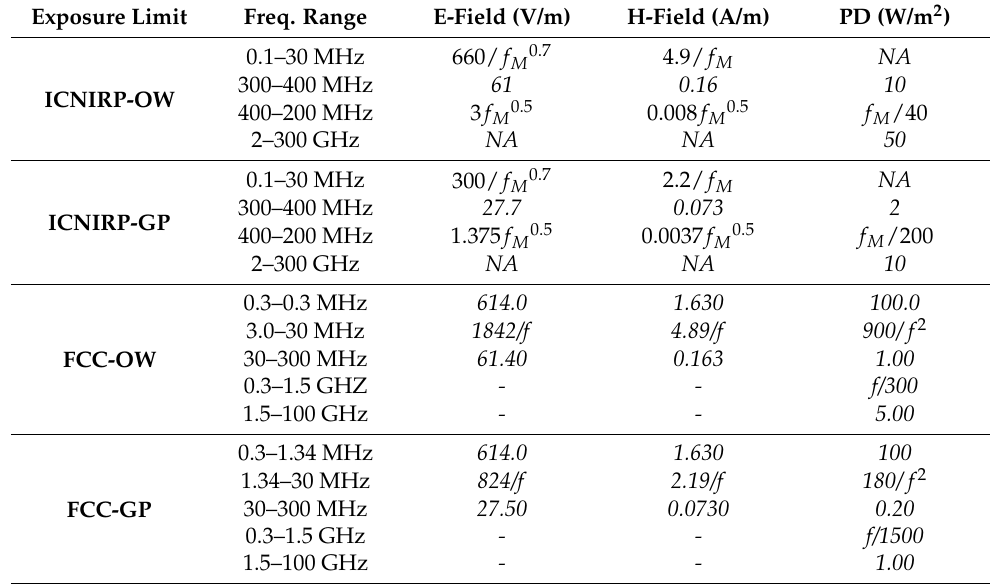
Table 1. The ICNIRP and FCC maximum limits for frequencies 0.1 MHz to 300 GHz. Exposure